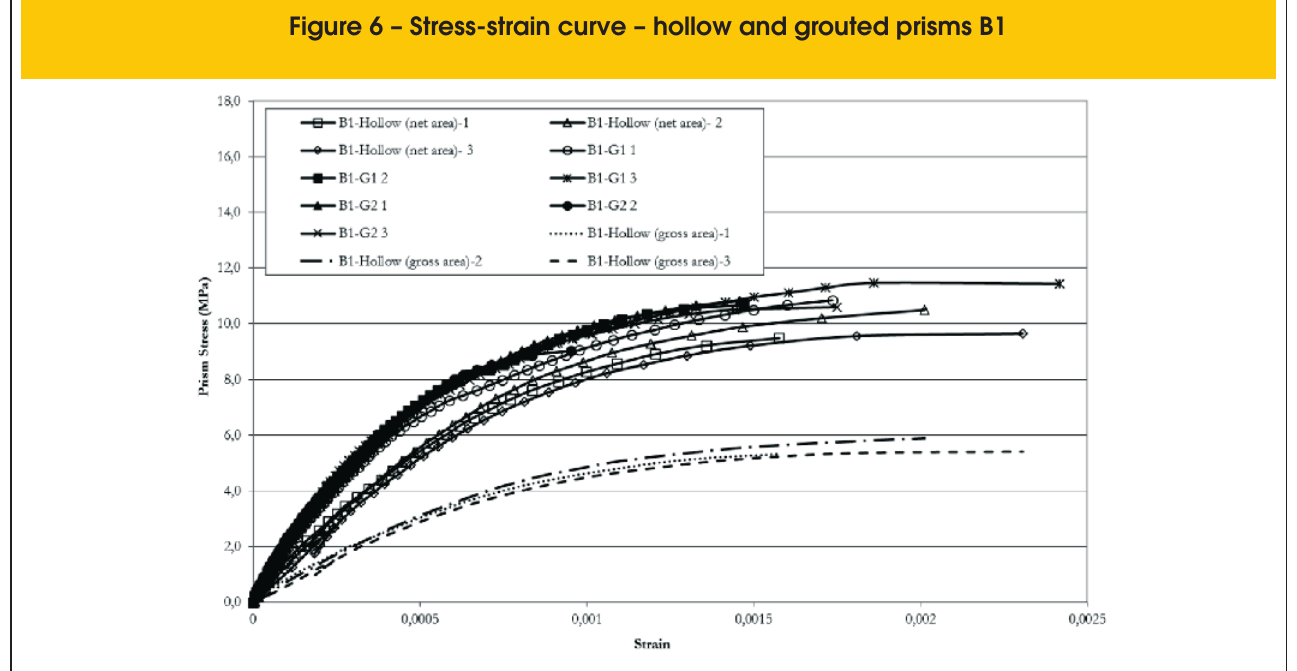
Figure 6 – Stress-strain curve – hollow and grouted prisms B1